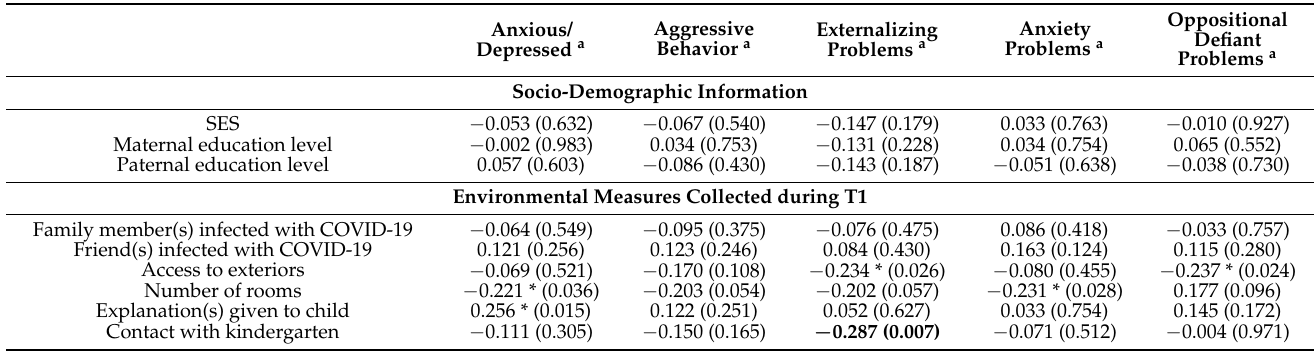
Table 4. Spearman correlation coefficient ( p -value) regarding associations between environmental variables and CBCL 1.5–5 scales showing significantly higher T scores at